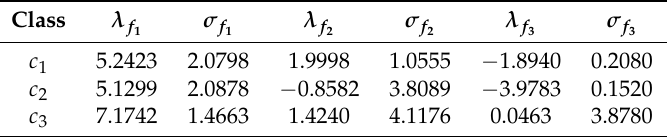
Table 7. Fall classification algorithm